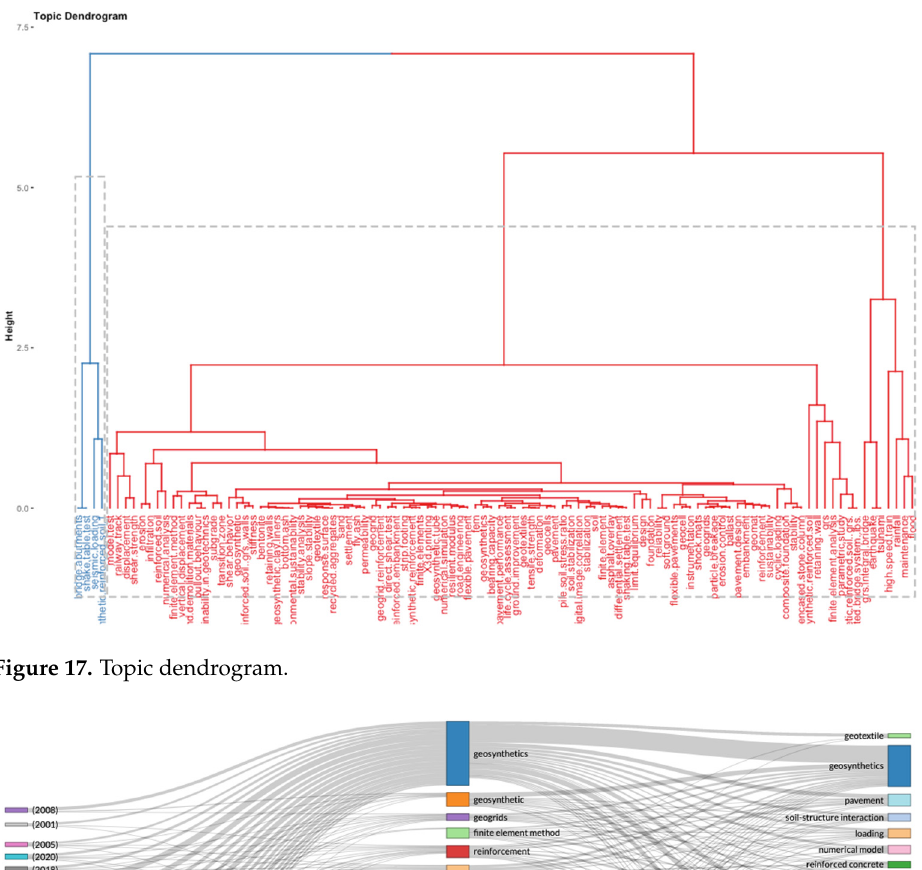
Figure 17. Topic dendrogram.